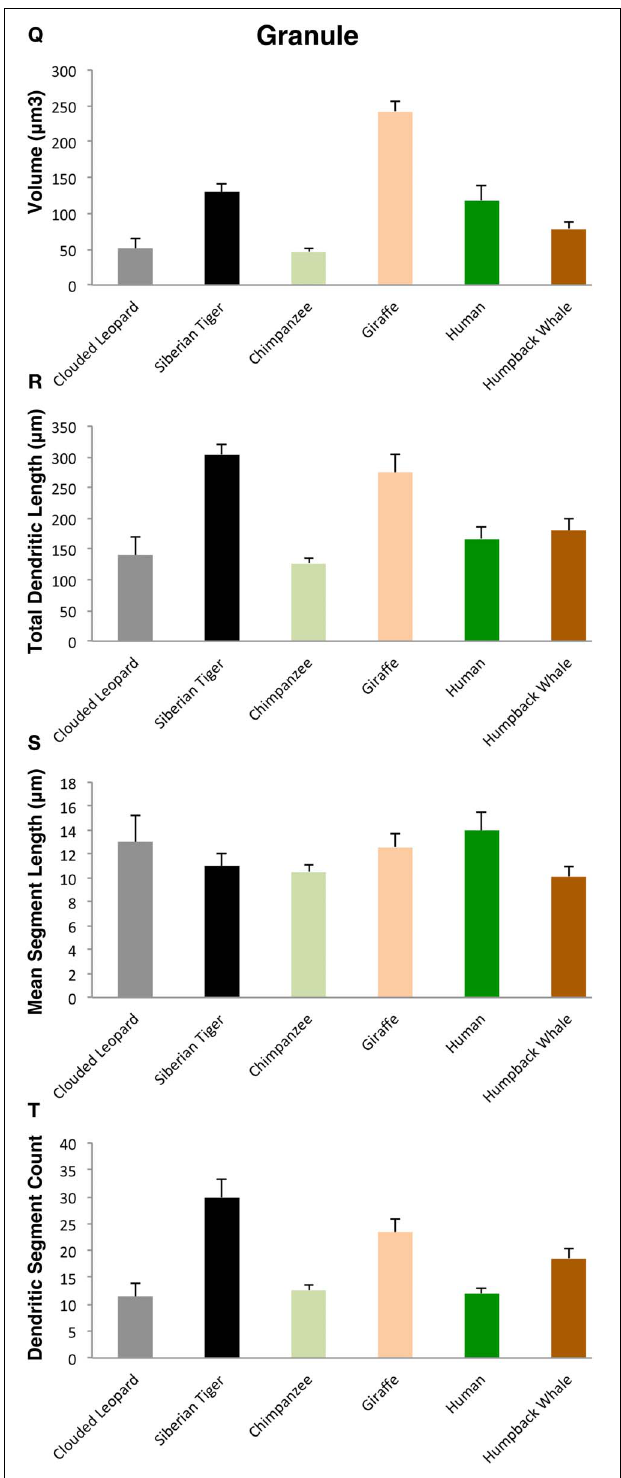
FIGURE 12 | Bar graphs indicated the relative values of four dependent measures (Volume, Total Dendritic Length, Mean Segment Length, and Dendritic Segment Count) for stellate (A–D), basket (E–H), Lugaro (I–L), Golgi (M–P), and granule (Q–T) neurons across the eight